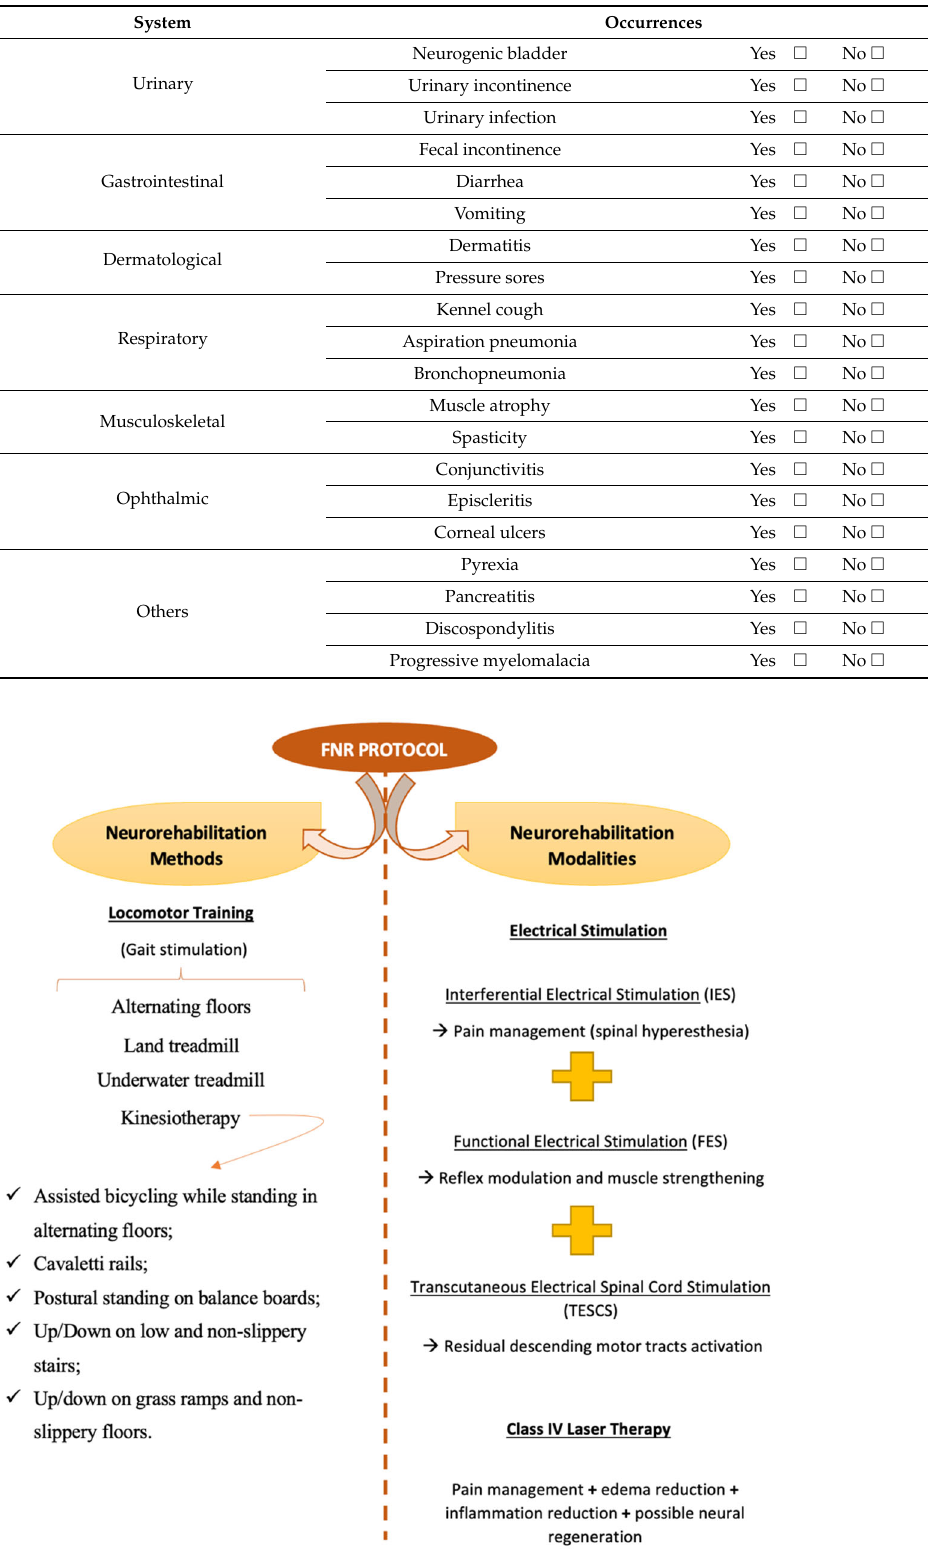
Table 2. Clinical occurrences check list.